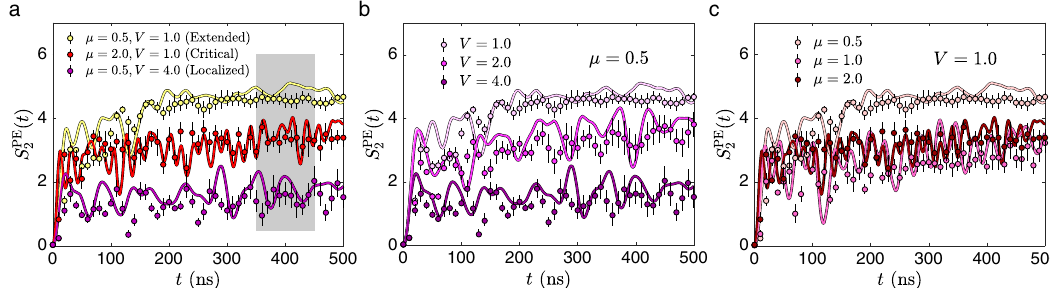
Fig. 3 Time evolution of participation entropy. a The dynamics of participation entropy for the system quenched into the three phases. The yellow, red, and purple points are experimental data for the extended ( μ = 0.5, V = 1.0), critical ( μ = 2.0, V = 1.0), and localized ( μ = 0.5, V = 4.0) phases, respectively. The dynamics of participation entropy with ( b ) fi xed μ = 0.5 and varying V = 1 to 4, and ( c ) fi xed V = 1 and varying μ = 0.5 to 2. Lines with the same color as points are numerical simulation under the same parameters with decoherence taken into account. Error bars represent the standard deviation.